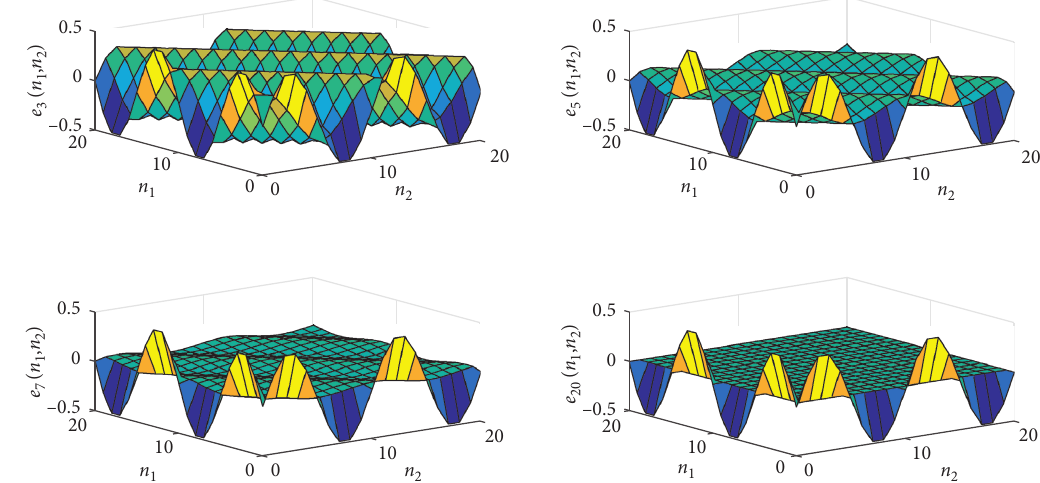
Figure 3: Under ILC law (45), the tracking error surface e